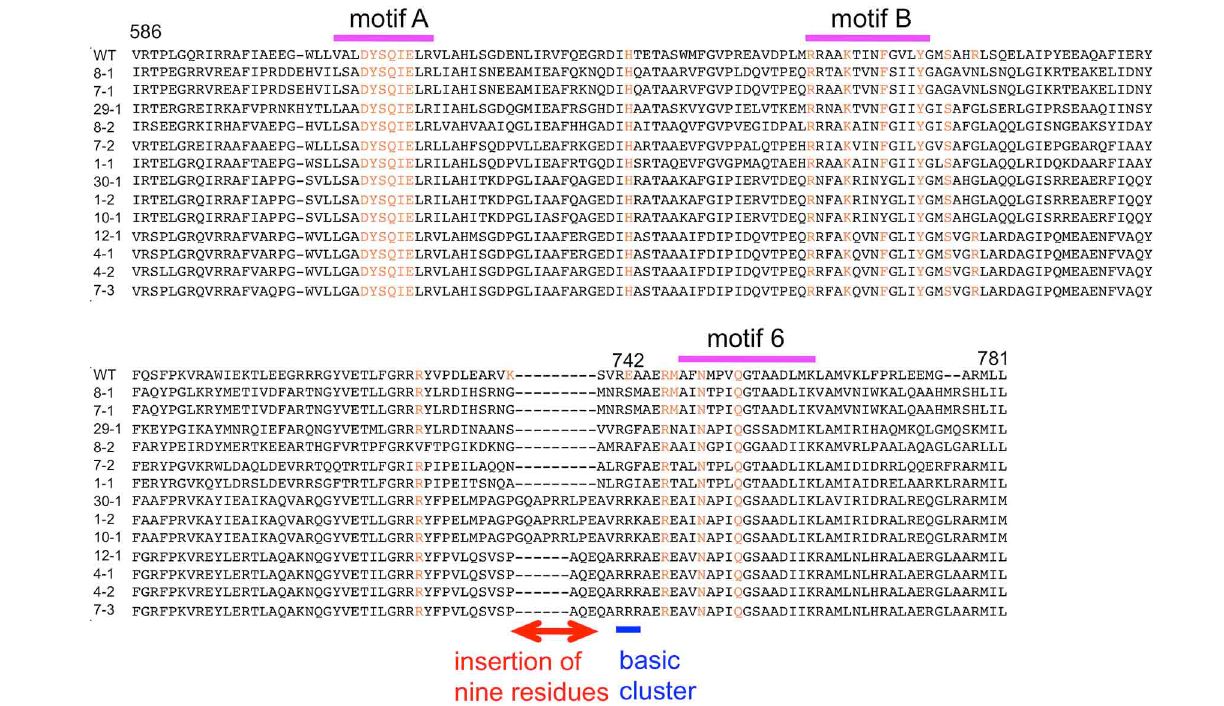
corresponding residues involved in binding the template DNA and ddCTP, identified by the crystal structures of Klentaq (Li et al., 1998), are colored orange. The distinctive region observed in this alignment is indicated by a red line with two arrowheads. The basic cluster is indicated by a blue line.